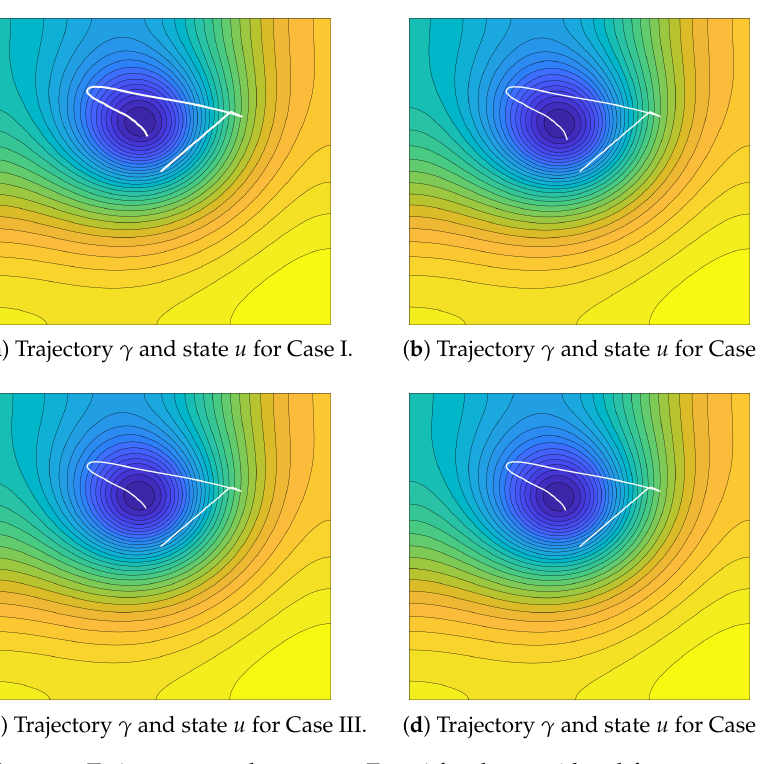
Figure 6. Trajectory γ and state u at T = 6 for the considered four cases with a minimal and a maximal value detailed in Table 5.